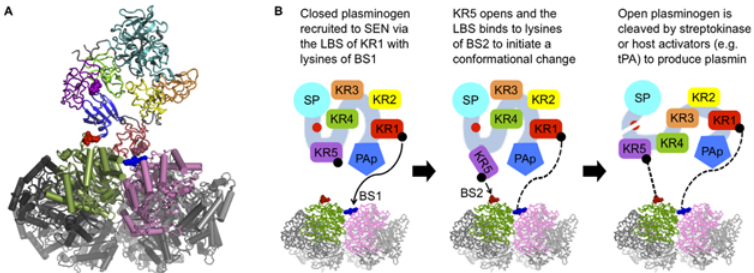
Fig 9. Molecular docking results and mechanism of plasminogen binding by SEN. ( A ) Human plasminogen KR1 docked at the SEN minor interface. Plasminogen domains are colored as follows: pan- apple (PAp) domain blue; KR1 red; KR2 yellow; KR3 orange; KR4 green; KR5 purple; serine protease (SP) domain cyan. Linear three-residue patches on KR1 and KR5 implicated in lysine binding are shown as spheres. One SEN dimer is colored green and pink, respectively, with the remaining octamer colored in shades of grey. One occurrence of SEN BS1 and BS2 is shown as blue and red spheres, respectively. ( B ) Proposed model for the binding of plasminogen by SEN involving interactions between BS1 and KR1, and BS2 and KR5. The color scheme follows (A) . Figure adapted from Law et al .